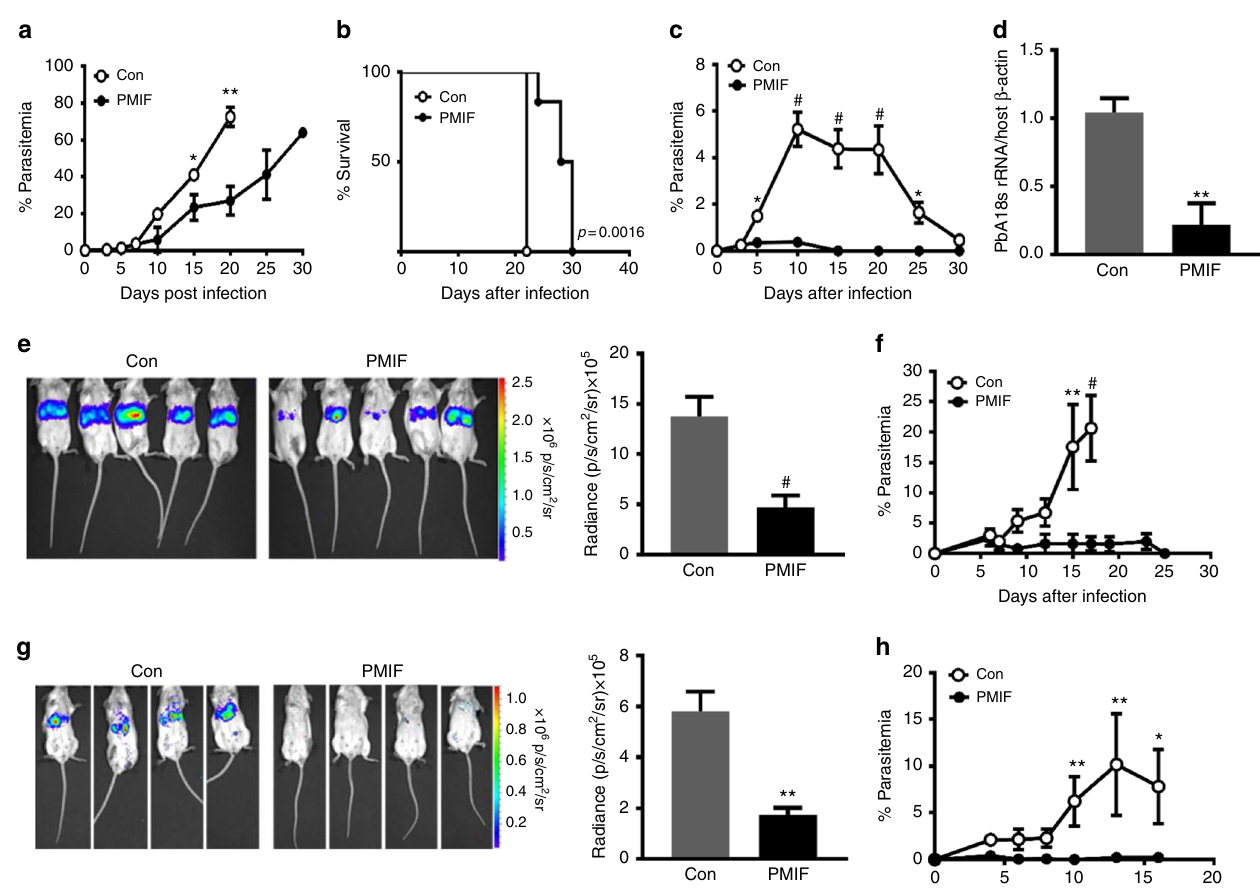
Fig. 3 PMIF neutralization confers complete protection to re-infection by wild type P. berghei ANKA. a Parasitemia after infection of BALB/cJ mice (10 6 Pb AWT iRBCs) previously immunized with RNA replicons encoding PMIF (black circle) or a control (Con) RNA (white circle); * p < 0.05, ** p < 0.01, by two- way ANOVA and error bars denote ±SD. b Kaplan – Meier survival plots for immunized mice following infection with Pb AWT (black circle, PMIF and white circle, Con). Data are from two independent experiments with 10 – 15 animals per group; ** p = 0.0016 by log-rank (Mantel Cox) test. c Percentage of iRBCs in BALB/cJ mice previously immunized with RNA encoding PMIF (black circle) or Con RNA (white circle), treated with chloroquine, and re-infected with 10 6 Pb AWT iRBCs; * p < 0.05, # p < 0.0001 by two-way ANOVA and error bars denote ±SD. d Splenic parasite load 6 days after reinfection with iRBCs was measured by quantitative PCR of Pb AWT 18S rRNA relative to host β -actin. Results are from two separate experiments. Bars represent the mean of